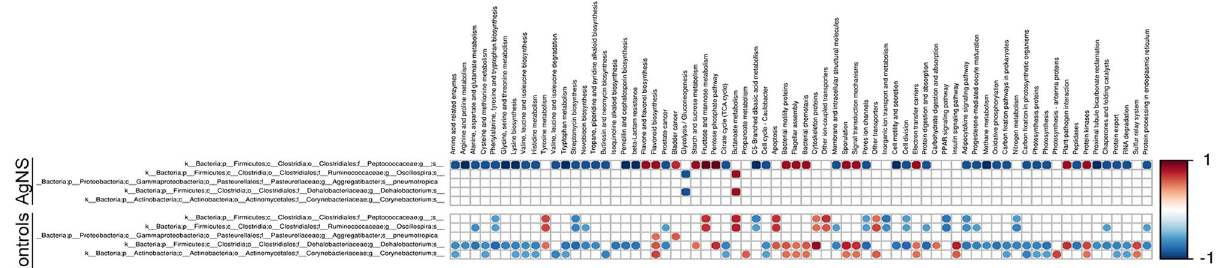
Figure 10. Bacterial metabolic and other pathway differences in the fecal samples of AgNS-treated individuals vs. controls. Data are presented as detailed in Fig.